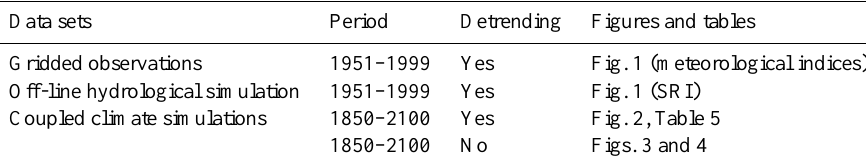
Table 3. Summary of the periods and methods used to compare meteorological vs. hydrological drought indices. Raw time series are used to analyse simulated climate change while detrended time series are preferred to discuss observed or simulated interannual variability.